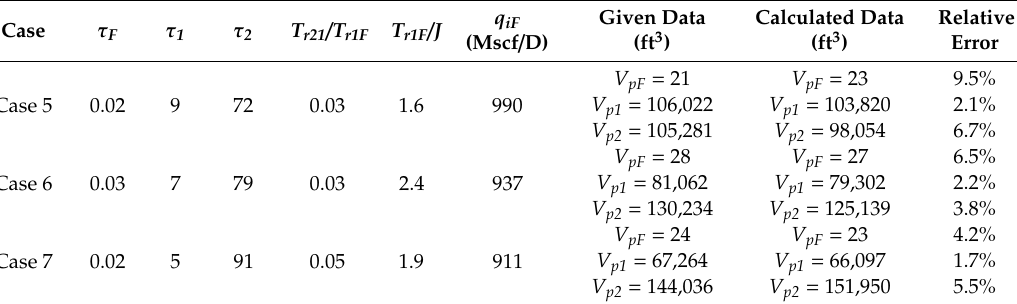
Figure 7. Comparison of the relationship of gas rate vs. pseudo-time from the numerical cases and new analytical solution. ( a ) Comparison of the relationship of gas rate vs. pseudo-time from the Case 5 and new model. ( b ) Comparison of the relationship of gas rate vs. pseudo-time from the Case 6 and new model. ( c ) Comparison of the relationship of gas rate vs. pseudo-time from the Case 7 and new model. Table 5. Inferred parameters value according to fitting